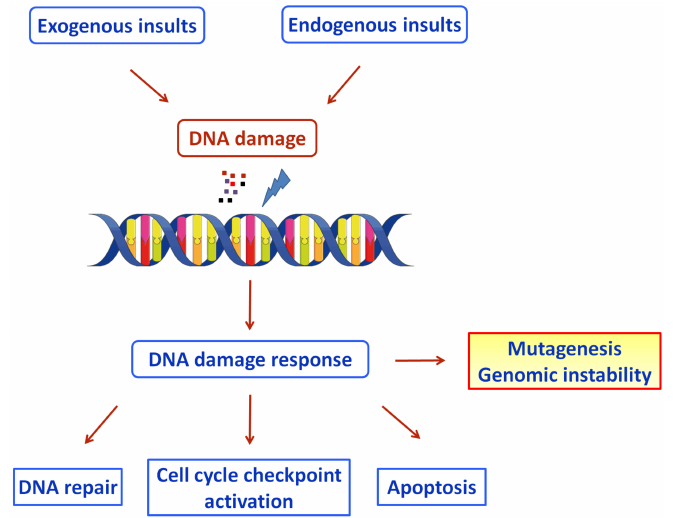
Figure 1. Schematic diagram of the DDR pathways activated by exogenous and endogenous insults (Figure was generated using images assembled from Servier Medical Art, https://smart.servier.com, accessed on 11 August